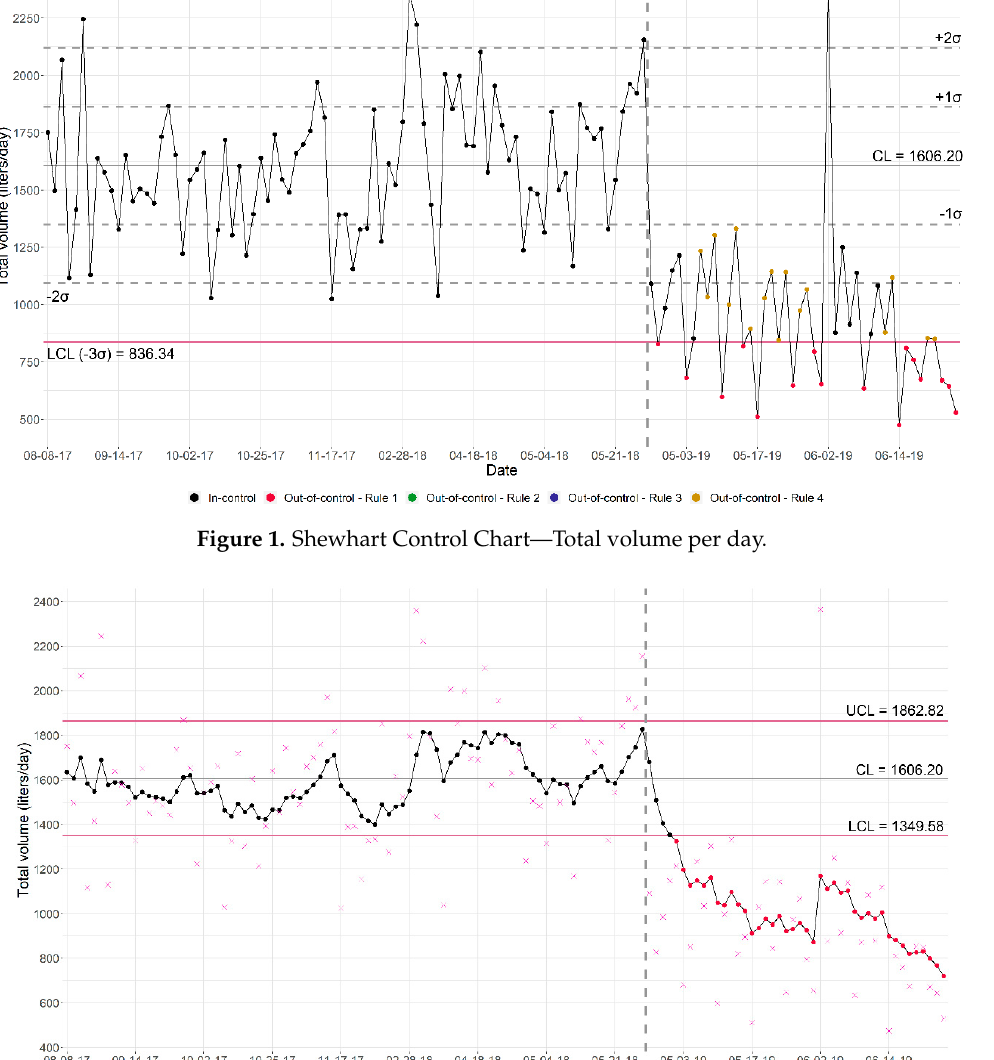
Figure 1. Shewhart Control Chart—Total volume per day.